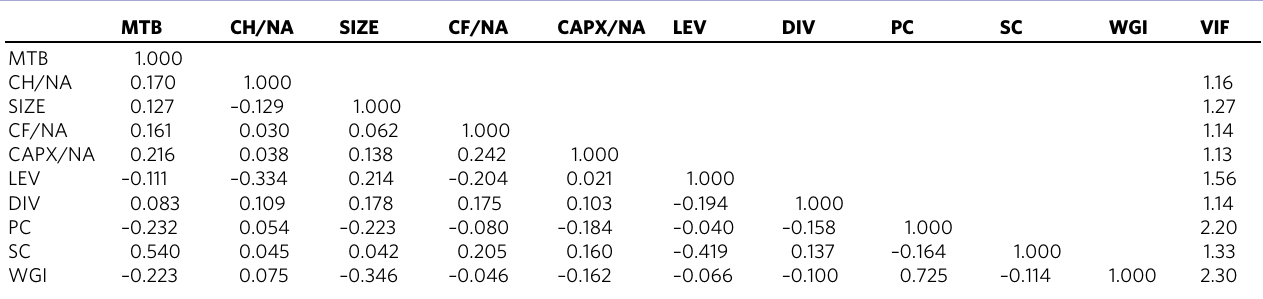
Table 3 Correlation matrix and variance in fl ation factors.